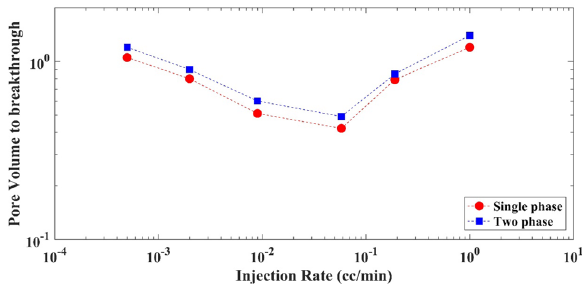
Fig. 9 Comparison of the two-phase and single-phase mode